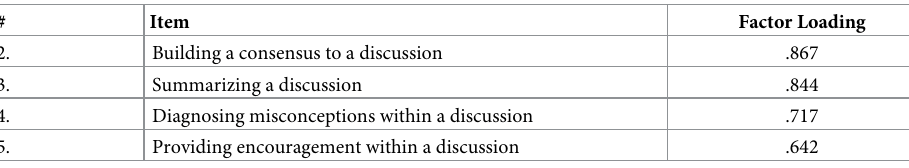
Table 4. Factor 2 –direct